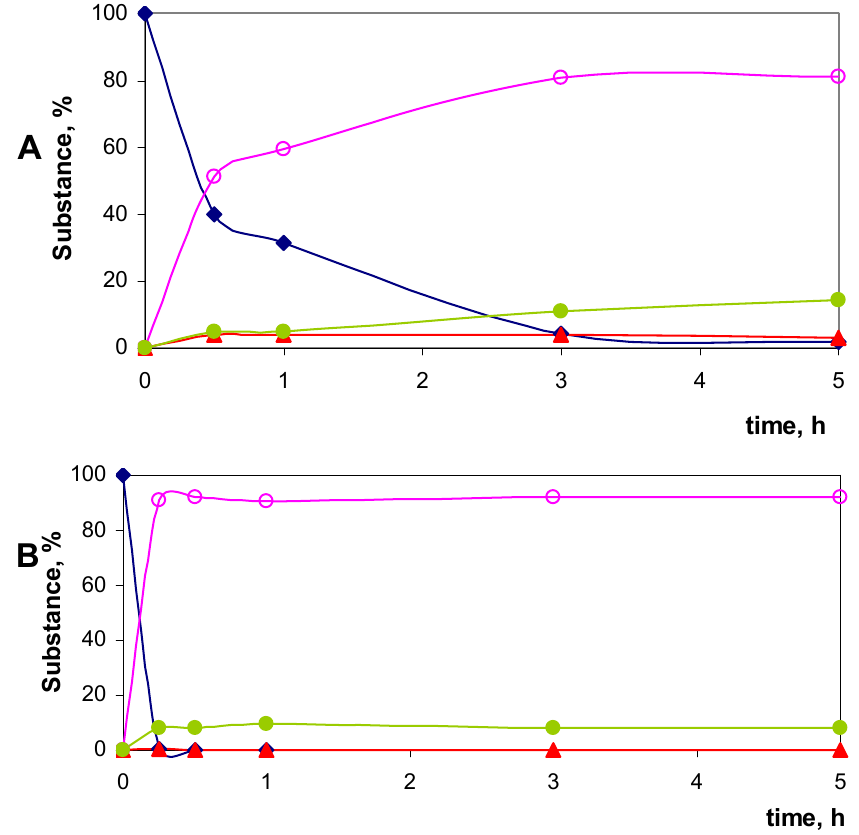
Fig. 1 Alkylation of indole sodium salt with 1-iodobutane (in [mmim] [OTs] at: A) 25 ◦ C; B) 80 ◦ C, where: a) (cid:2) – indole; b) ◦ – 1-butyl indole; c) (cid:3) – 3-butyl